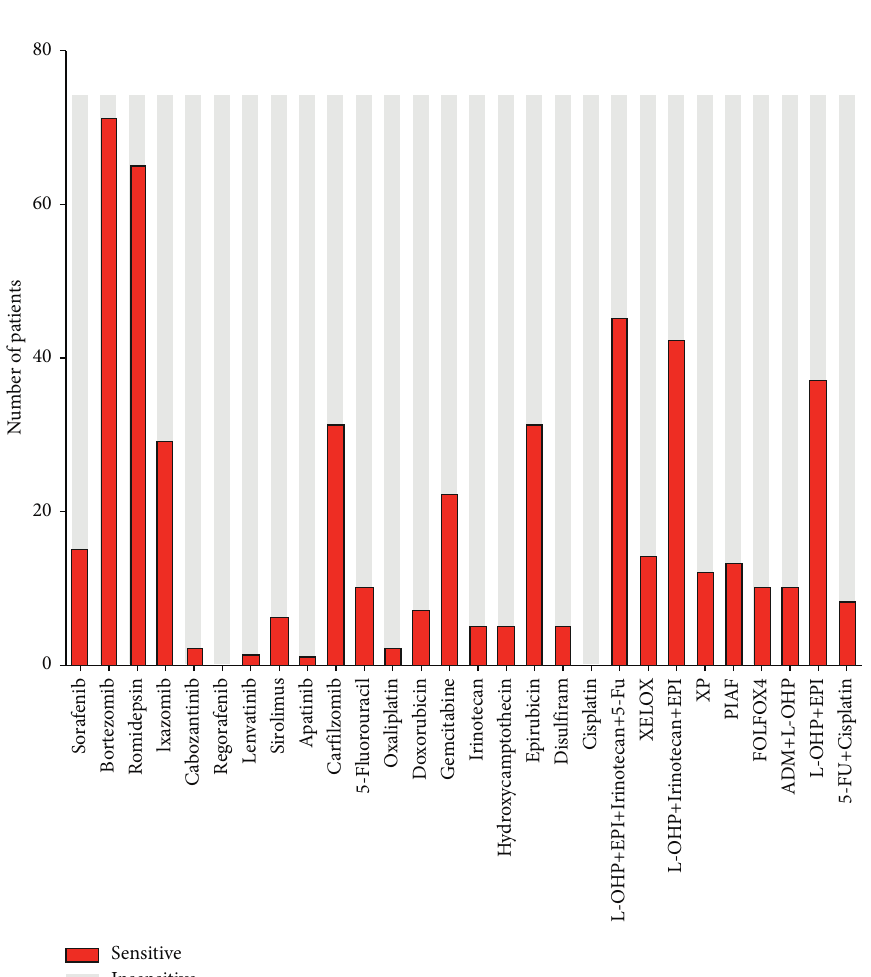
Figure 2: In vitro high-throughput drug sensitivity screening